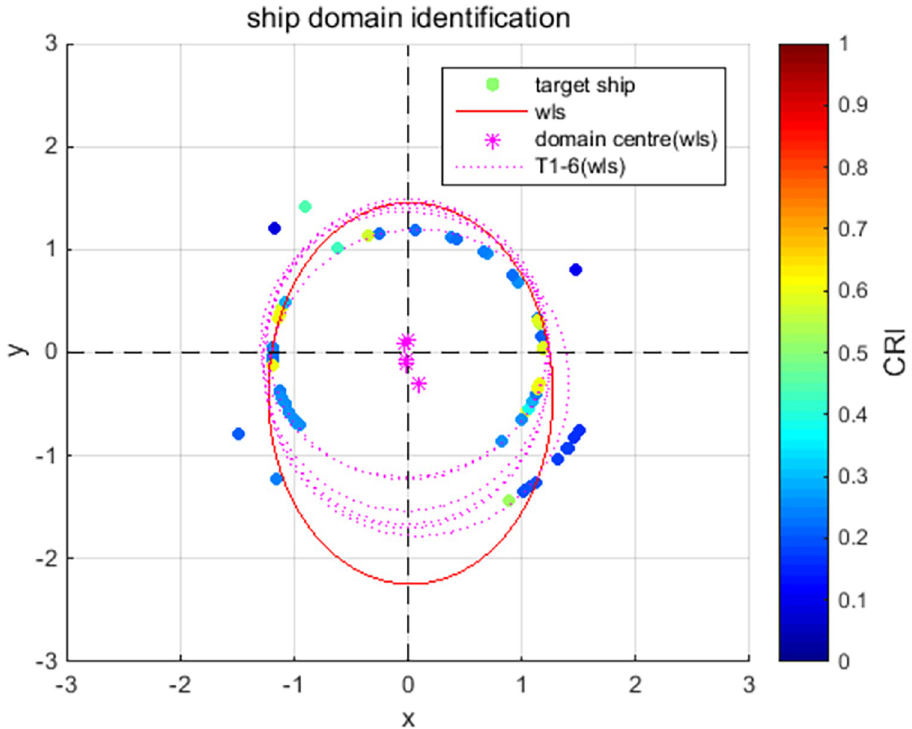
Fig 12. Overlying ship domains by